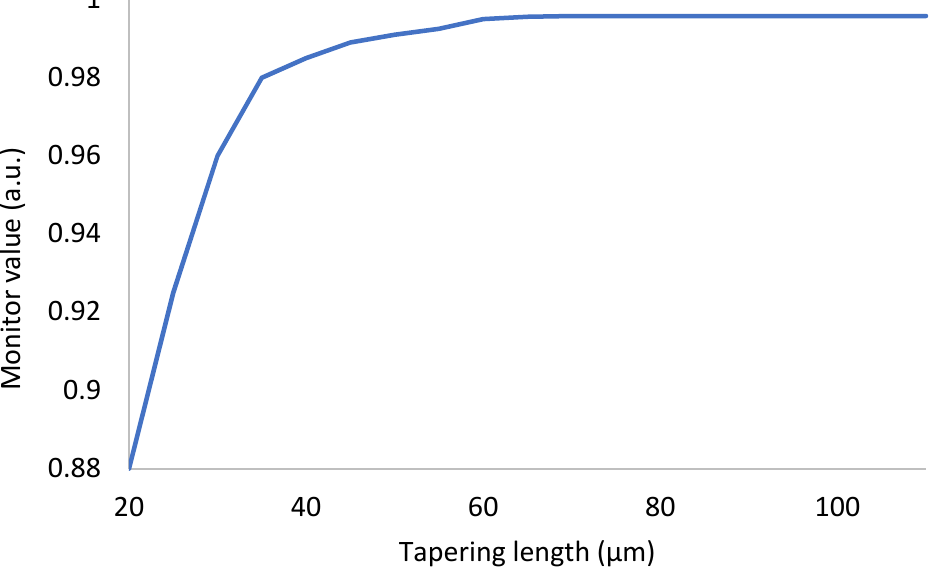
Figure 7. The results of DSCF’s transmitted light when polished from 1.5 µm to 0.75 µm with different tapering lengths.